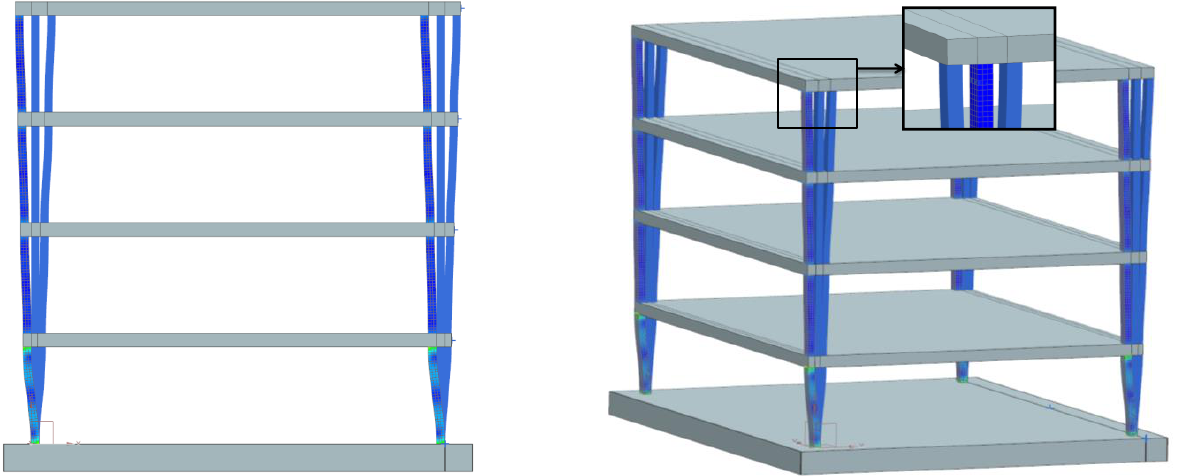
Figure 14. Maximum building deflection recorded during the simulation of a system without the use of vibration-reducing force.